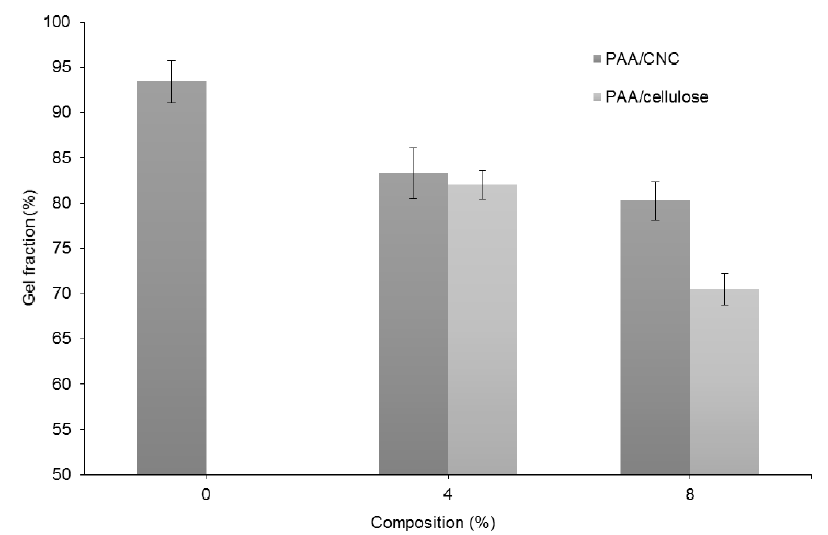
Figure 5. Effect of cellulose and CNC composition on the gel fraction of PAA hydrogels.